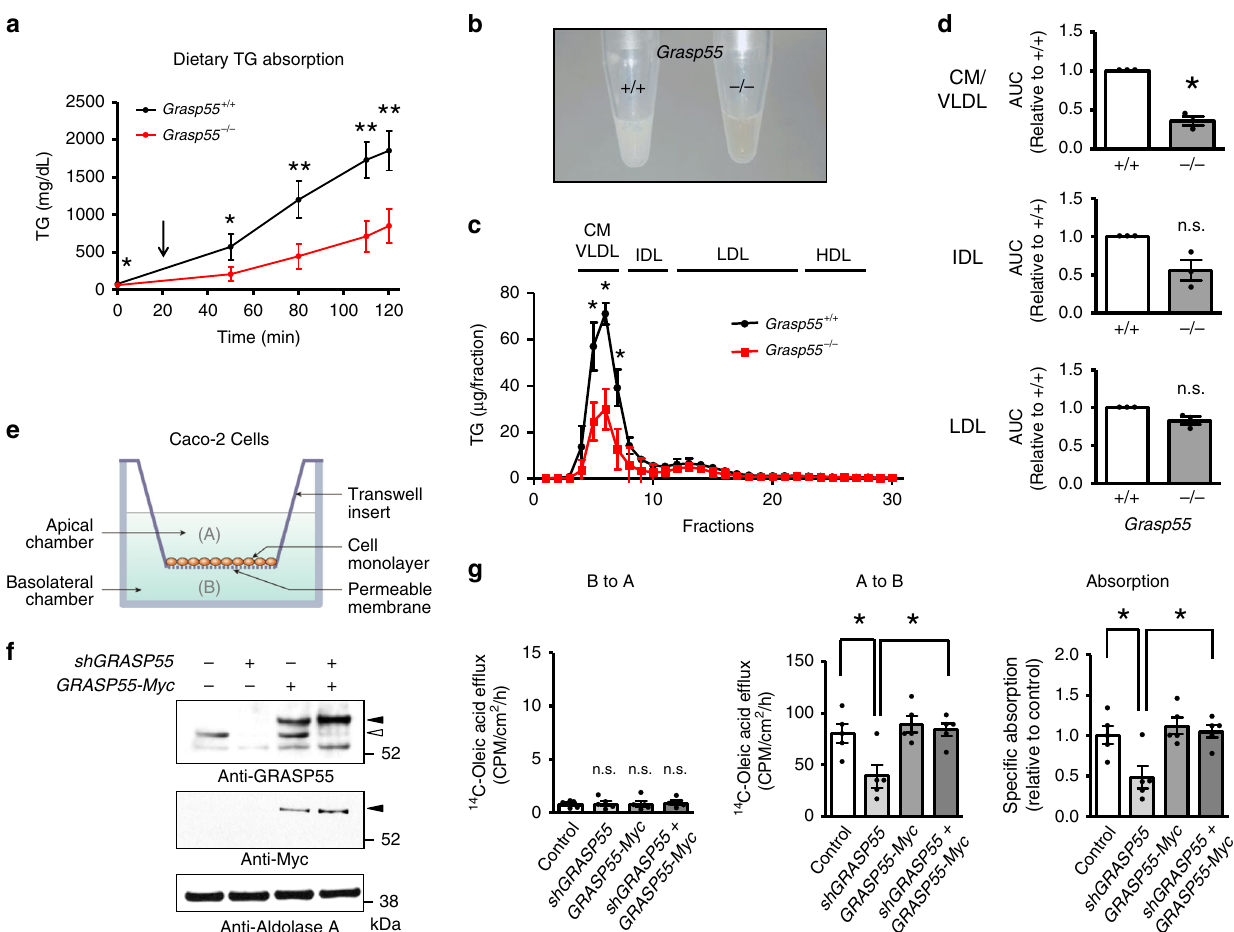
Fig. 4 GRASP55 is required for intestinal fat absorption and chylomicron secretion. a An oral fat tolerance test was performed with 12-week-old male mice after oral gavage of olive oil (10 μ l g − 1 of body weight). Tyloxapol (Triton WR-1339) was administered 20 min after the olive oil gavage (arrow, 0.5